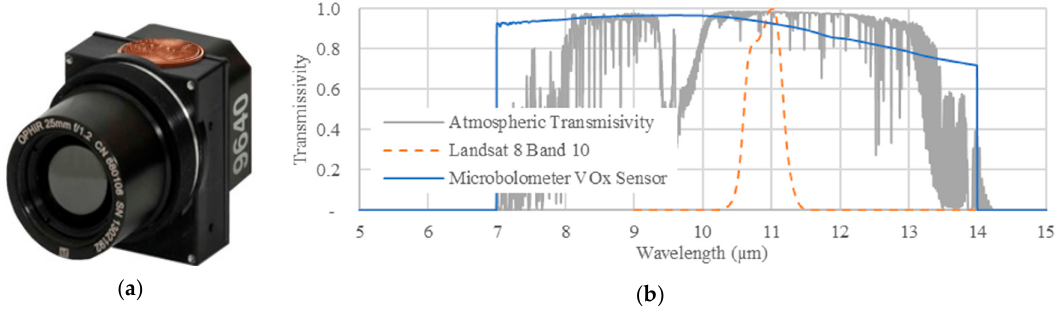
Figure 1. Example of the dimensions of a microbolometer ICI Camera 9640 Series, used in this study ( a ). VOx Spectral Response in the 7 to 14 μ m Filter, Landsat 8 Band 10 spectral response and average atmospheric transmissivity in the long infrared region ( b ).